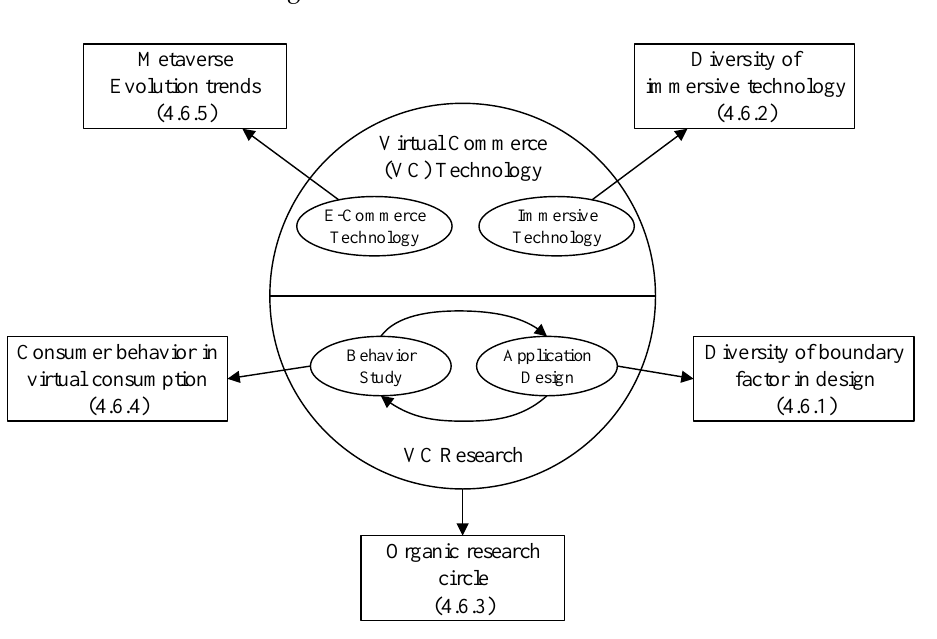
Figure 11. Research gaps and future research